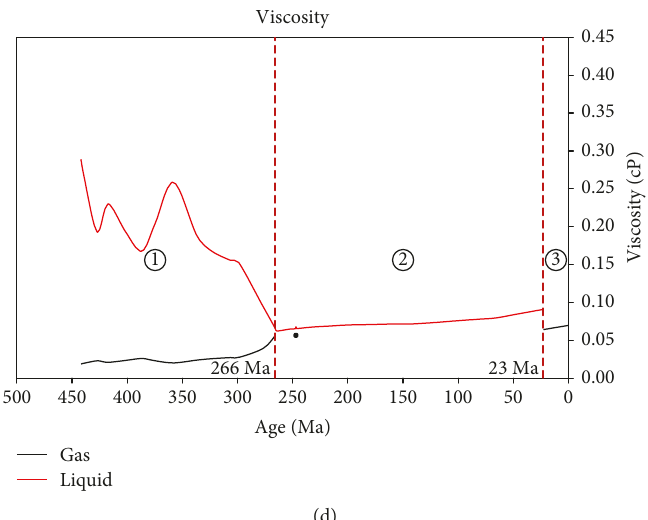
Figure 12: The evolution of the density and viscosity of the fl uid in the Lianglitage Formation, taking gas washing into account. (a, b) 100% gas washing degree; (c, d) 50% gas washing degree. ① : coexisting gas and liquid phases; ② : liquid phase; and ③ : condensate gas